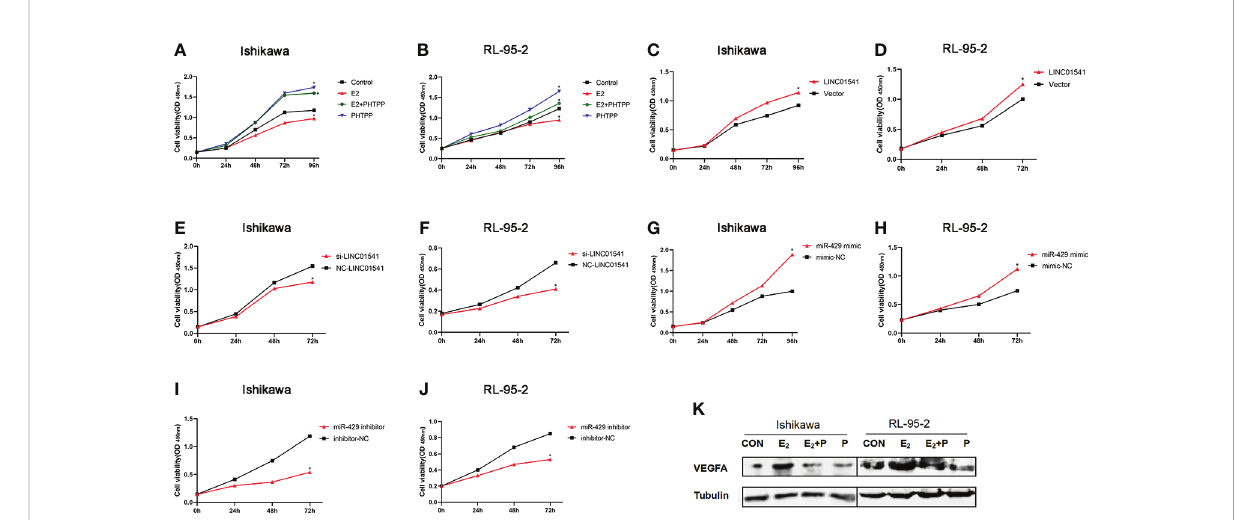
FIGURE 3 CCK-8 and Western blot analysis were used to analyze the effects of treatment. (A, B) In Ishikawa and RL95-2 cells, E2 inhibited cell proliferation, whereas PHTPP and a mixture of PHTPP and E2 promoted cell proliferation. (C, D) Overexpression of LINC01541 promoted proliferation of both cell lines. (E, F) Interfering with the expression of LINC01541 inhibited proliferation of both cell lines. (G, H) Overexpression of miR-429 promoted proliferation of both cell lines. (I, J) Silencing the expression of miR-429 inhibited proliferation of both cell lines. (K) Compared with the control group, E2 promoted the expression of VEGFA, whereas PHTPP inhibited the expression of VEGFA; a mixture of the two had an intermediate effect on VEGFA in Ishikawa and RL95-2 cells. (* P <0.05).